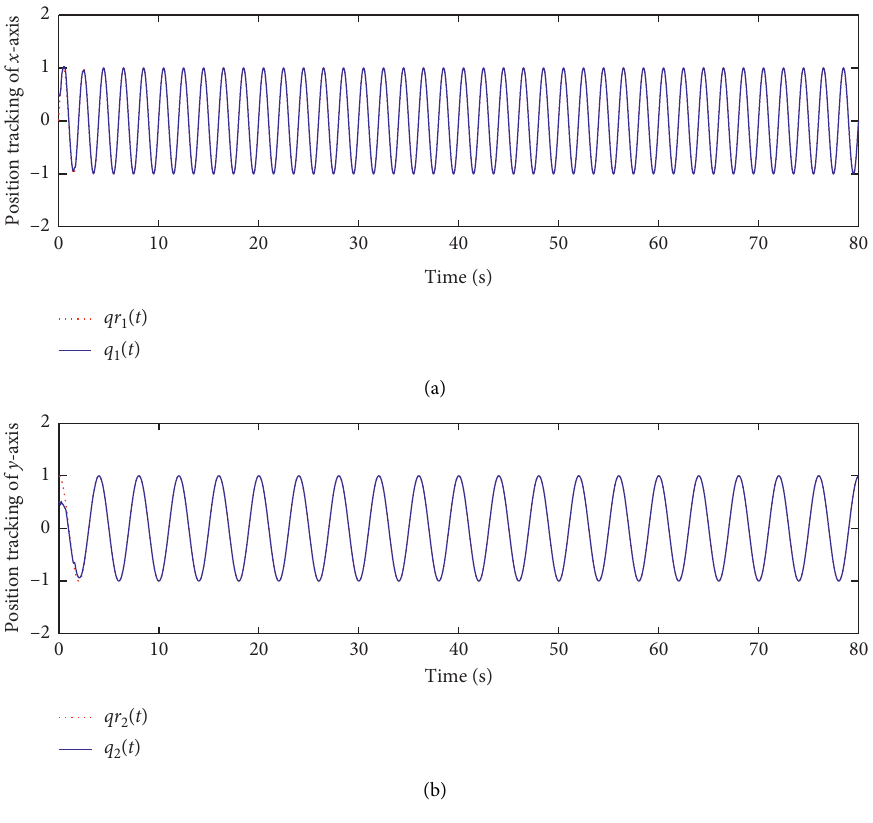
Figure 3: Tracking trajectory using fractional fast TSM surface.